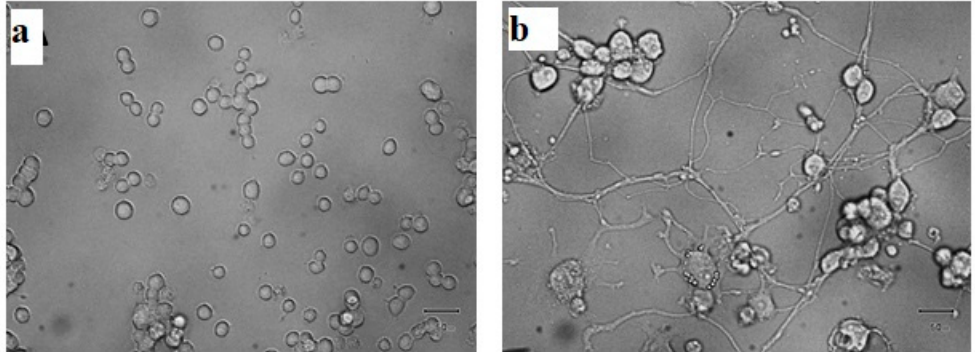
Figure 8. NGF-dependent neuronal phenotype differentiation of PC12 cells. Representative photomicrographs obtained by microscopy of PC12 cells untreated ( a ) or treated with 50 ng/mL NGF ( b ) for 72 h. Scale bar = 50 µm.